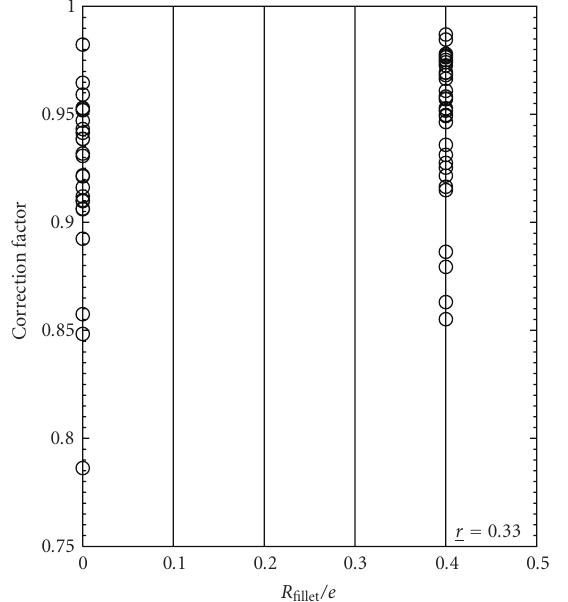
Figure 12: Correction factor variation with h rib for the set of chosen data.